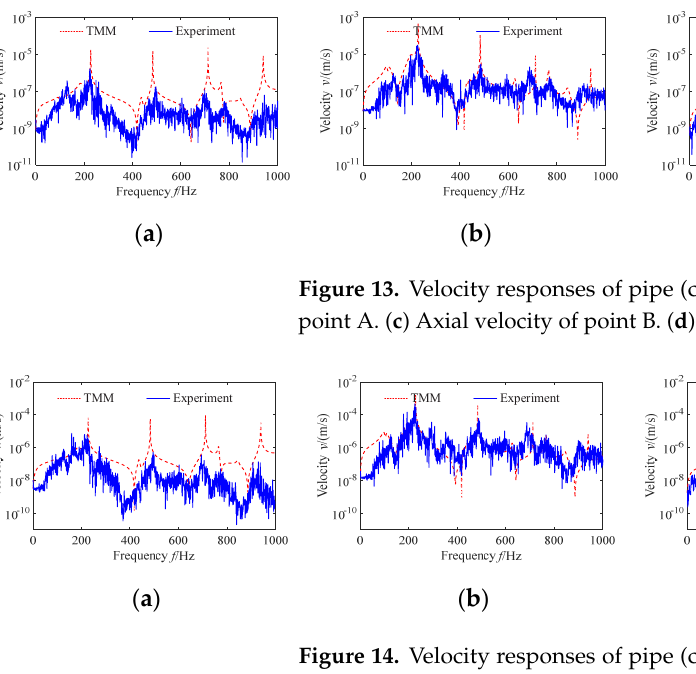
Figure 13. Velocity responses of pipe (case 1). ( a ) Axial velocity of point A. ( b ) Radial velocity of point A. ( c ) Axial velocity of point B. ( d ) Radial velocity of point B. Table 9. Resonant frequencies of pipe (case 1).